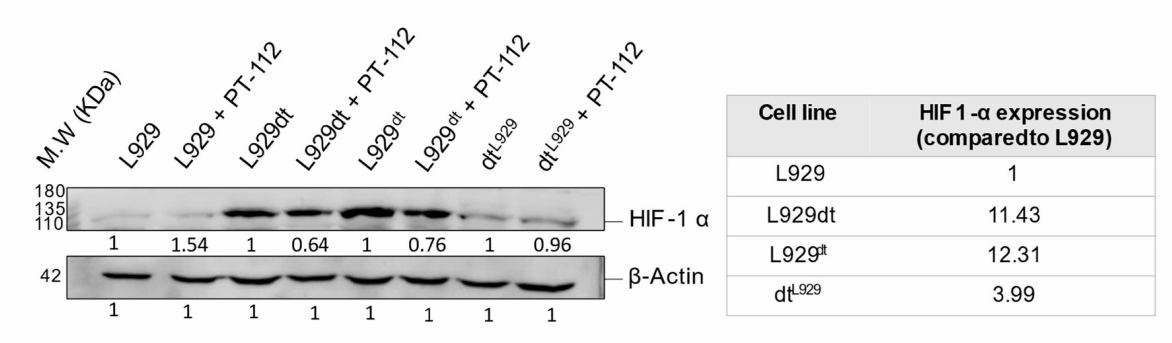
Figure 11. Analysis of HIF-1 α expression levels in the presence or absence of PT-112. Cells were incu- bated with 10 µ M of PT-112 for 72 h. Cell lysates were resolved in an SDS-PAGE 6% polyacrylamide gel, and proteins were transferred to nitrocellulose membrane and incubated with a specific antibody against HIF-1 α . β -actin was used as a control of the protein loaded. The table shows the percentage of protein expression in basal conditions compared to parental L929 cells. The uncropped blots are shown in Figure